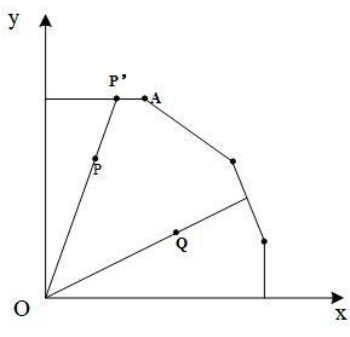
Figure 1. Slack variable schematic.